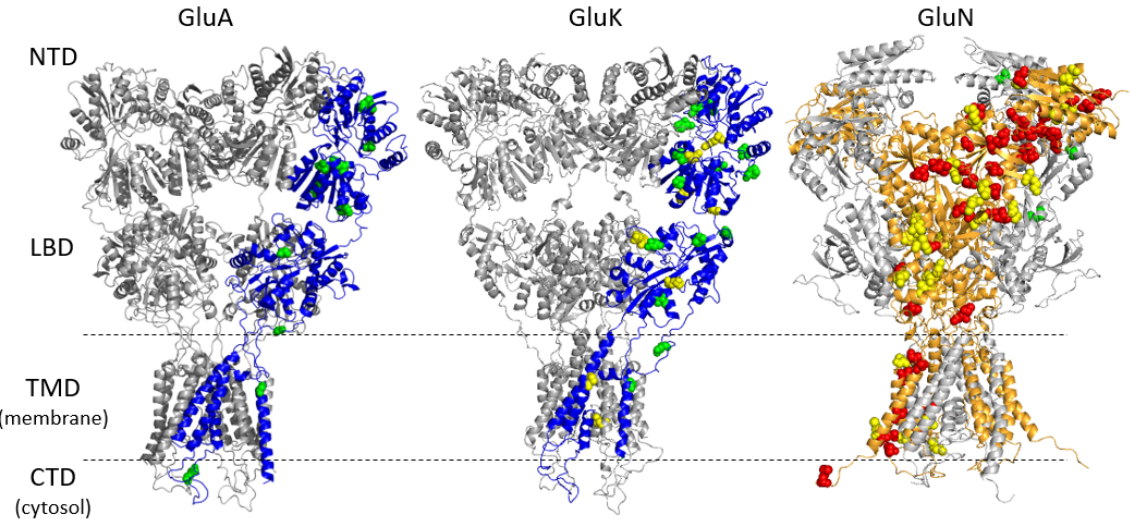
Figure 1. Positions of missense variants found in iGluR subunits. The structures of GluA and GluK represent a prototypical homomeric receptor. Green and yellow residues in the GluA or GluK subunit (in blue) mark missense variants. The structure of GluN represents the heteromeric iGluR (obligatory GLuN1 subunits in gray, variable GluN2/N3 subunits in orange). Missense variants in the GluN1 subunit are depicted in green. Yellow and red residues in the GluN2/N3 subunit (in orange) mark missense variants found in some of the six subunits.